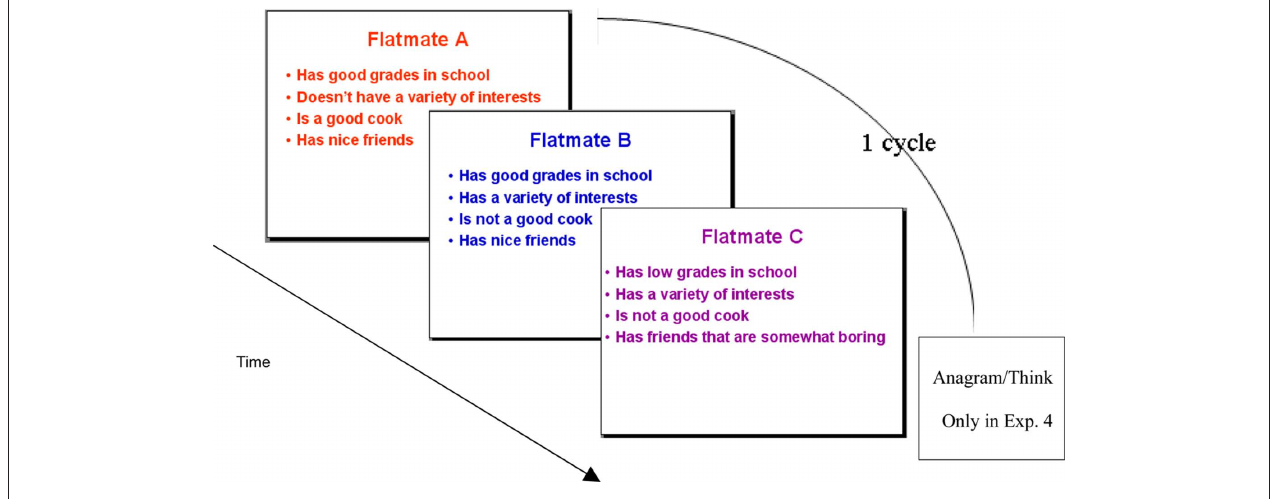
starts with four attributes of flatmate A, followed by four attributes of flatmate B, and last four attributes of flatmate C; the fourth box, Anagram/Think, only applies to Experiment 4. Three cycles of slides are presented, corresponding to a total of 12 attributes for each